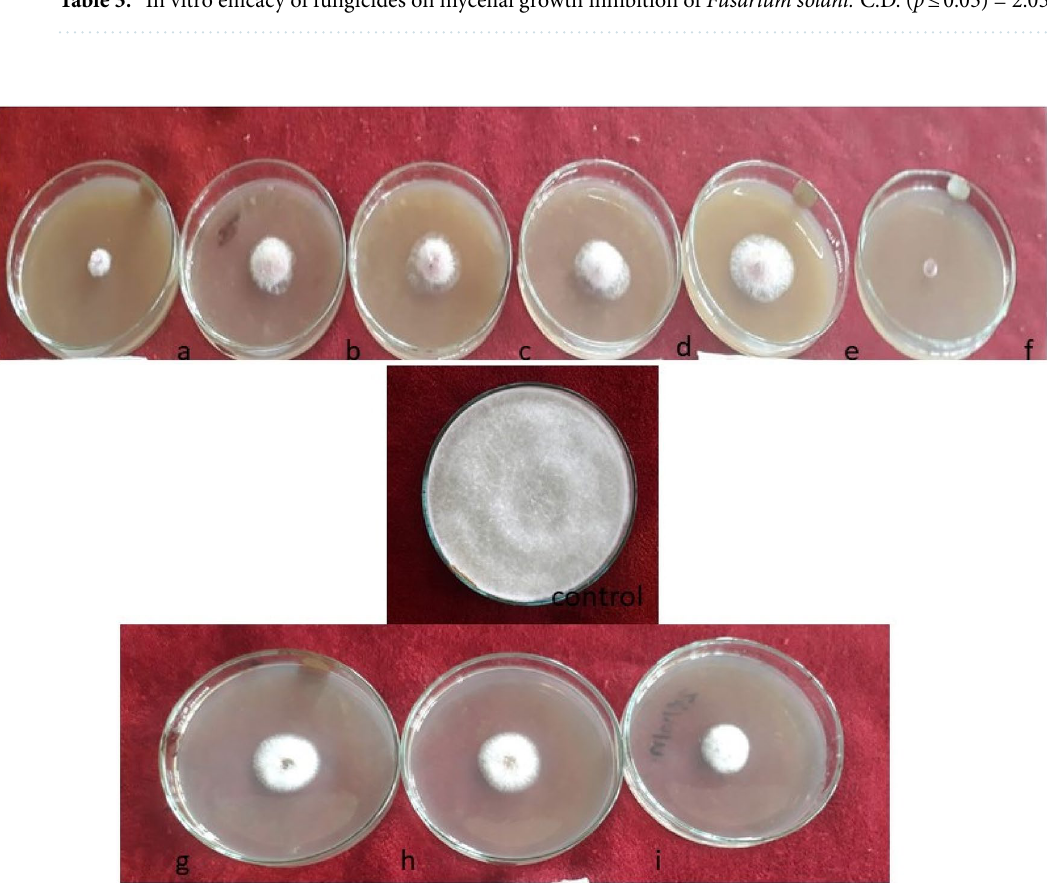
Table 3. In vitro efficacy of fungicides on mycelial growth inhibition of Fusarium solani. C.D. ( p ≤ 0.05) = 2.05.